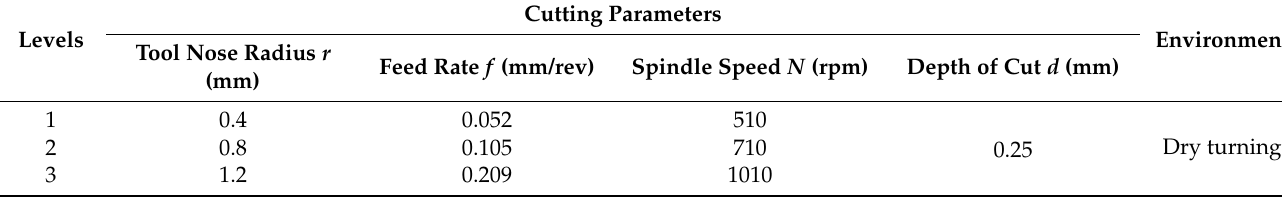
Figure 1. Schematic of experimental setup. Table 1. Experimental conditions for dry turning process.